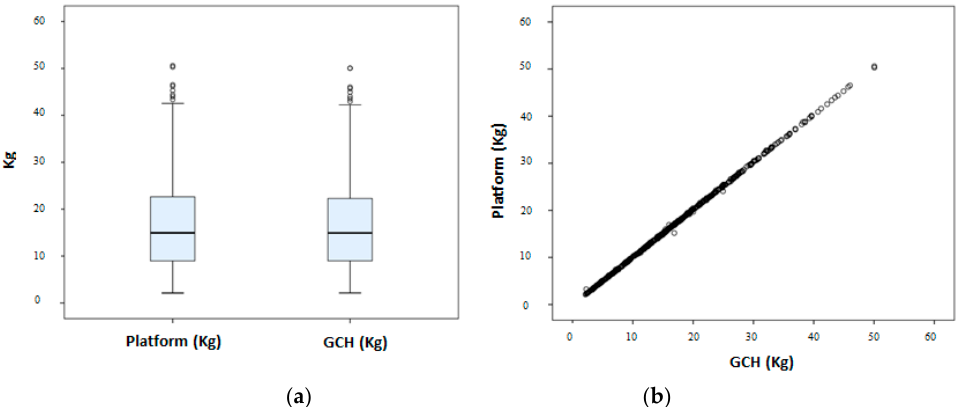
Figure 4. Box plot representing percentiles 25, 50 and 75 ( a ) and scatter plot ( b ) of the relationship between platform and GCH measurements.